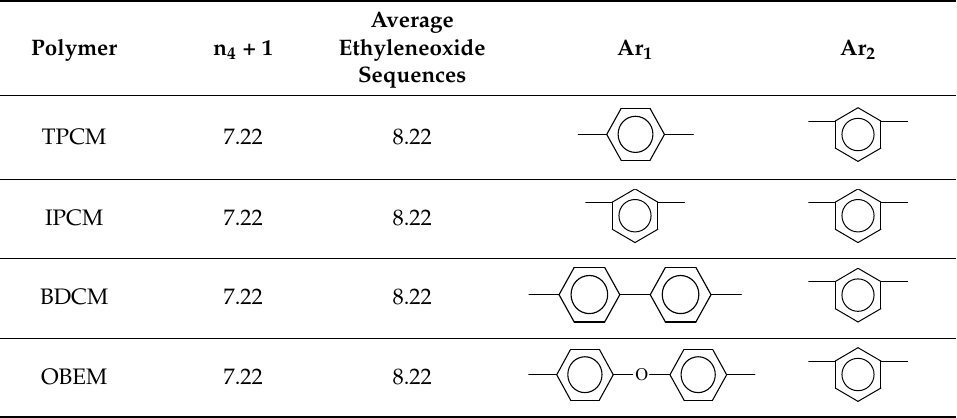
Figure 1. 1 H NMR of meta -oriented diamine 3b (in blue and red numbers the hydrogen assignation and the integrals, respectively). For the preparation of polyamides, IPC, TPB, BDC, and OBE were reacted with the three diamines to obtain twelve polymers (Scheme1 and Table 1). The diamines were pre- viously silylated in situ to increase the nucleophilicity of the amine group toward acid chloride. Thus, the polycondensation of monomers was carried out in solution at 0 °C using DMA as a solvent and TMSC as a molecular mass promoter. Results obtained in the synthesis of the polyamides are shown in Scheme 1. The range in the inherent viscosities of all the polymers was between 0.44 and 1.21 dL/g (Table 2). Spectroscopic methods were